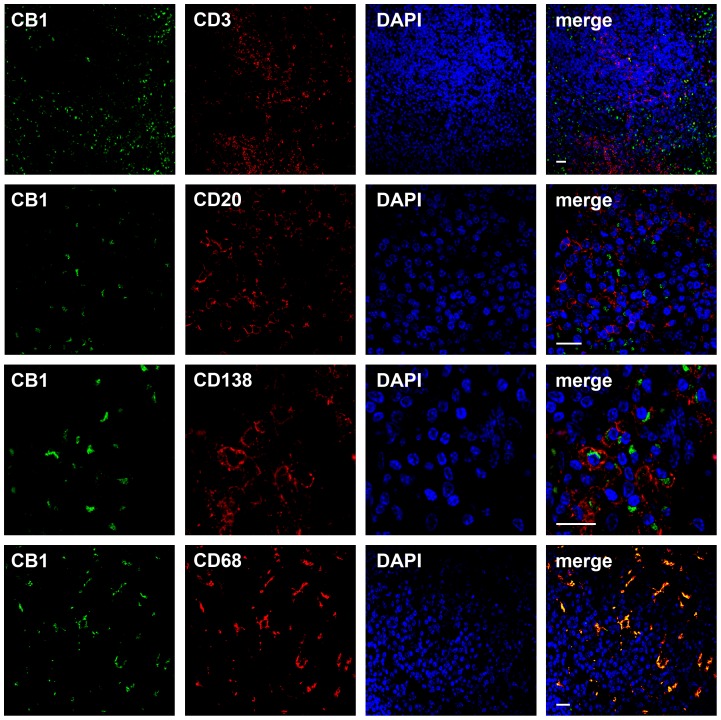
CB1 in reactive lymphoid tissue.Immunofluorescence staining and confocal imaging of a tonsil against CB1–N (green, left column), CD3, CD20, CD138 and CD68 (all in red, second left column). Nuclei were visualized using DAPI (blue, second right column). Right column represents merged images. CB1 signal was present in CD68+ macrophages and CD138+ plasma cells, not in CD3+ and CD20+ lymphocytes. Bars  =  20 µm.